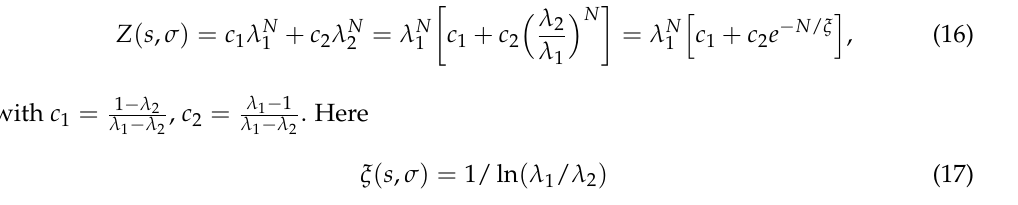
σ (not shown), the black − 0) asymptots s and 1. σ values and the color codes → 0.5 ; inset shows the comparison √ σ (cid:39)